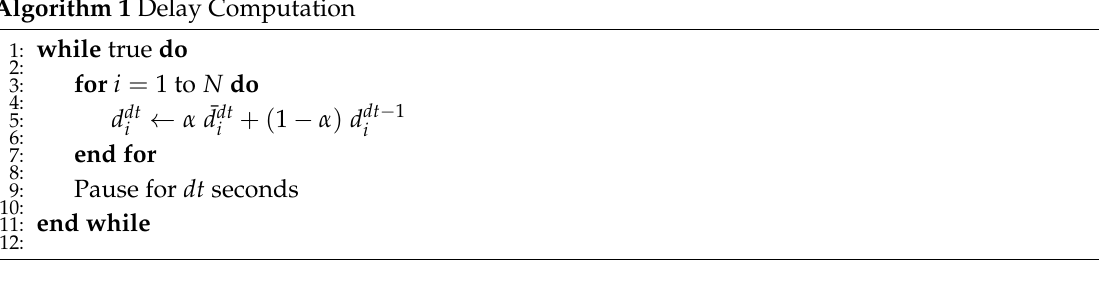
Algorithm 1 Delay Computation